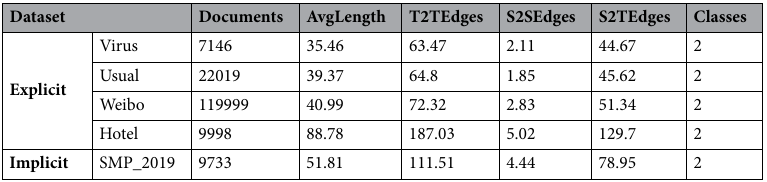
Table 1. Statistics of the target domain and source domain datasets. The AvgLength denotes the average number of tokens in each text; the T2TEdges, the S2SEdges, and the S2TEdges indicate the average number of times token-token, sentence-sentence, sentence-token edges occurrences in each text,